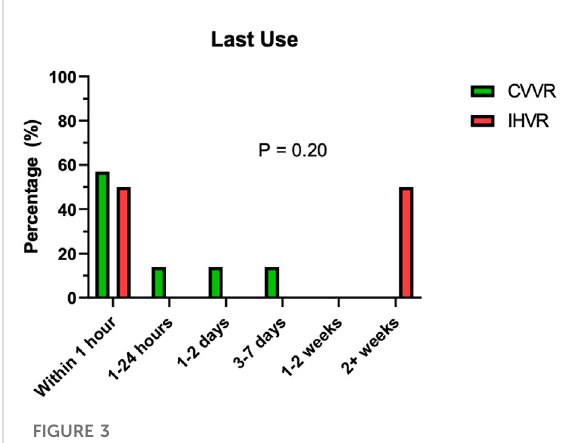
FIGURE 3 Distribution of time of last use of virtual reality technology prior to the actual procedure. The bar graph shows percentage ( y -axis) of trainees in CVVR (green) and IHVR (red) based on their last use of thevirtual reality technology ( x -axis). Fisher ’ sExact test ( p = 0.20) shows no difference between the two groups for last use of virtual reality